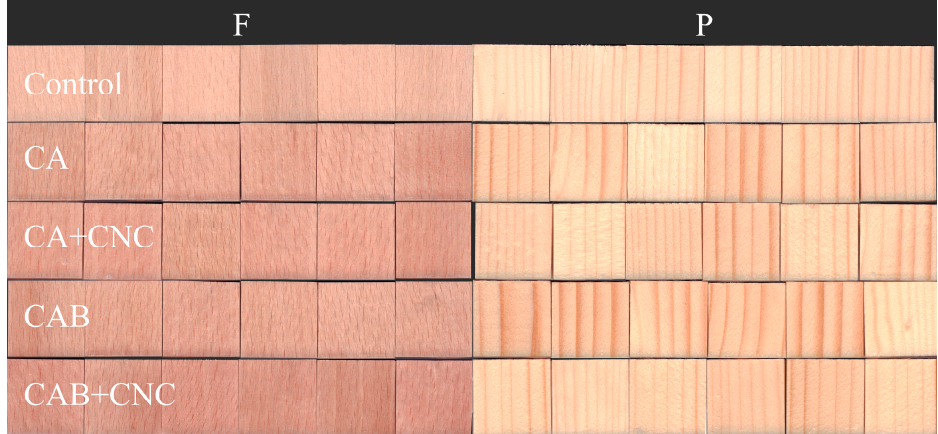
Figure 3. General appearance of the formulated coatings referred to uncoated wood. Control: Un-